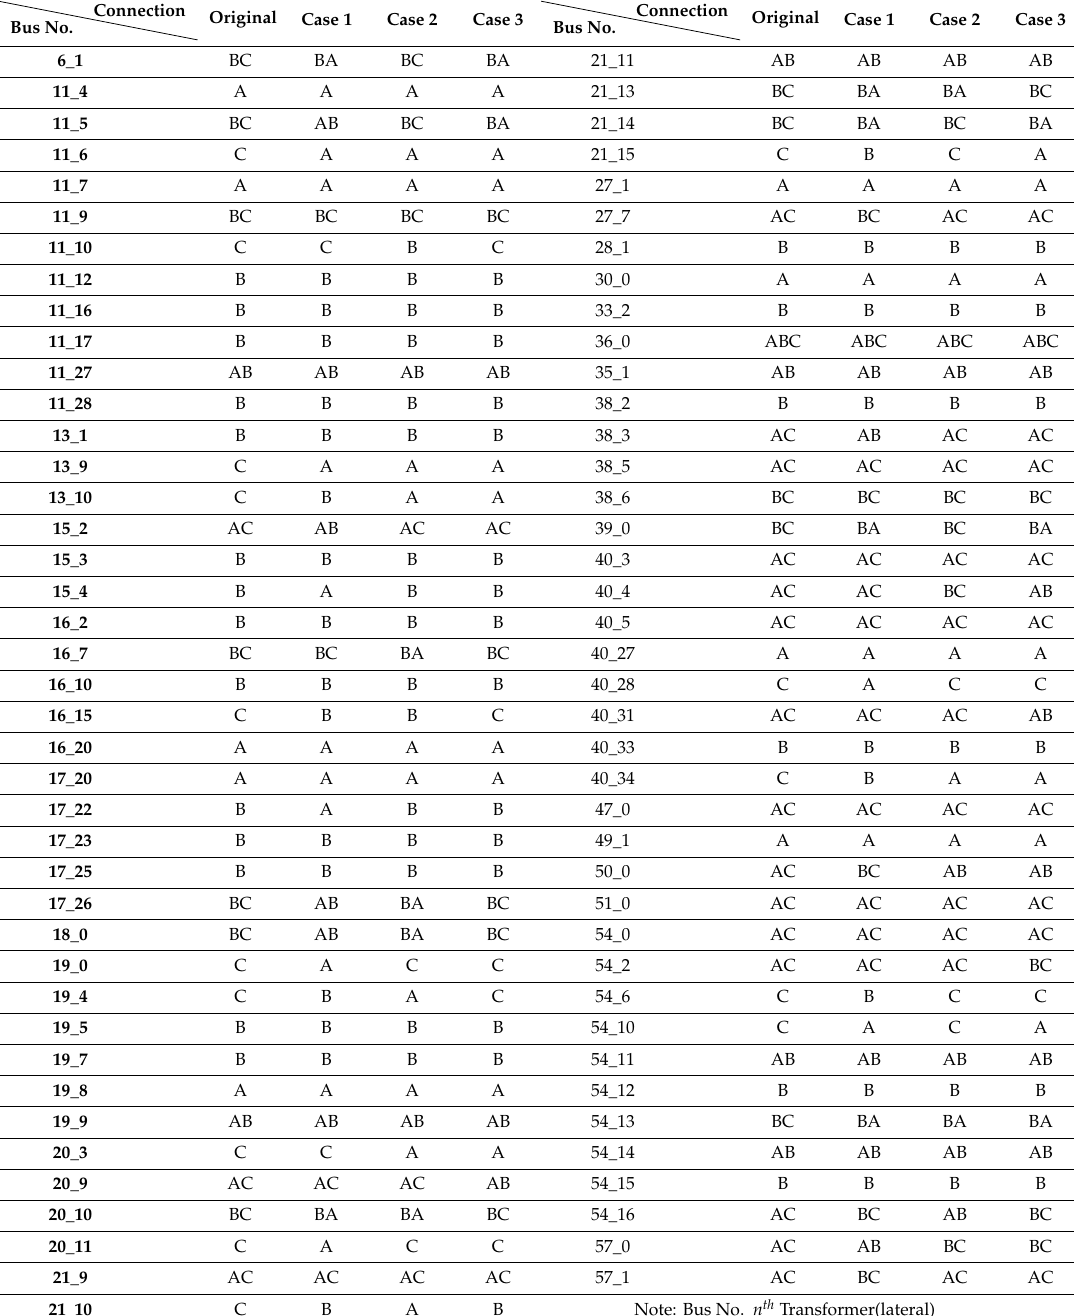
Table 3. Optimal phase arrangement comparisons of four cases with the original